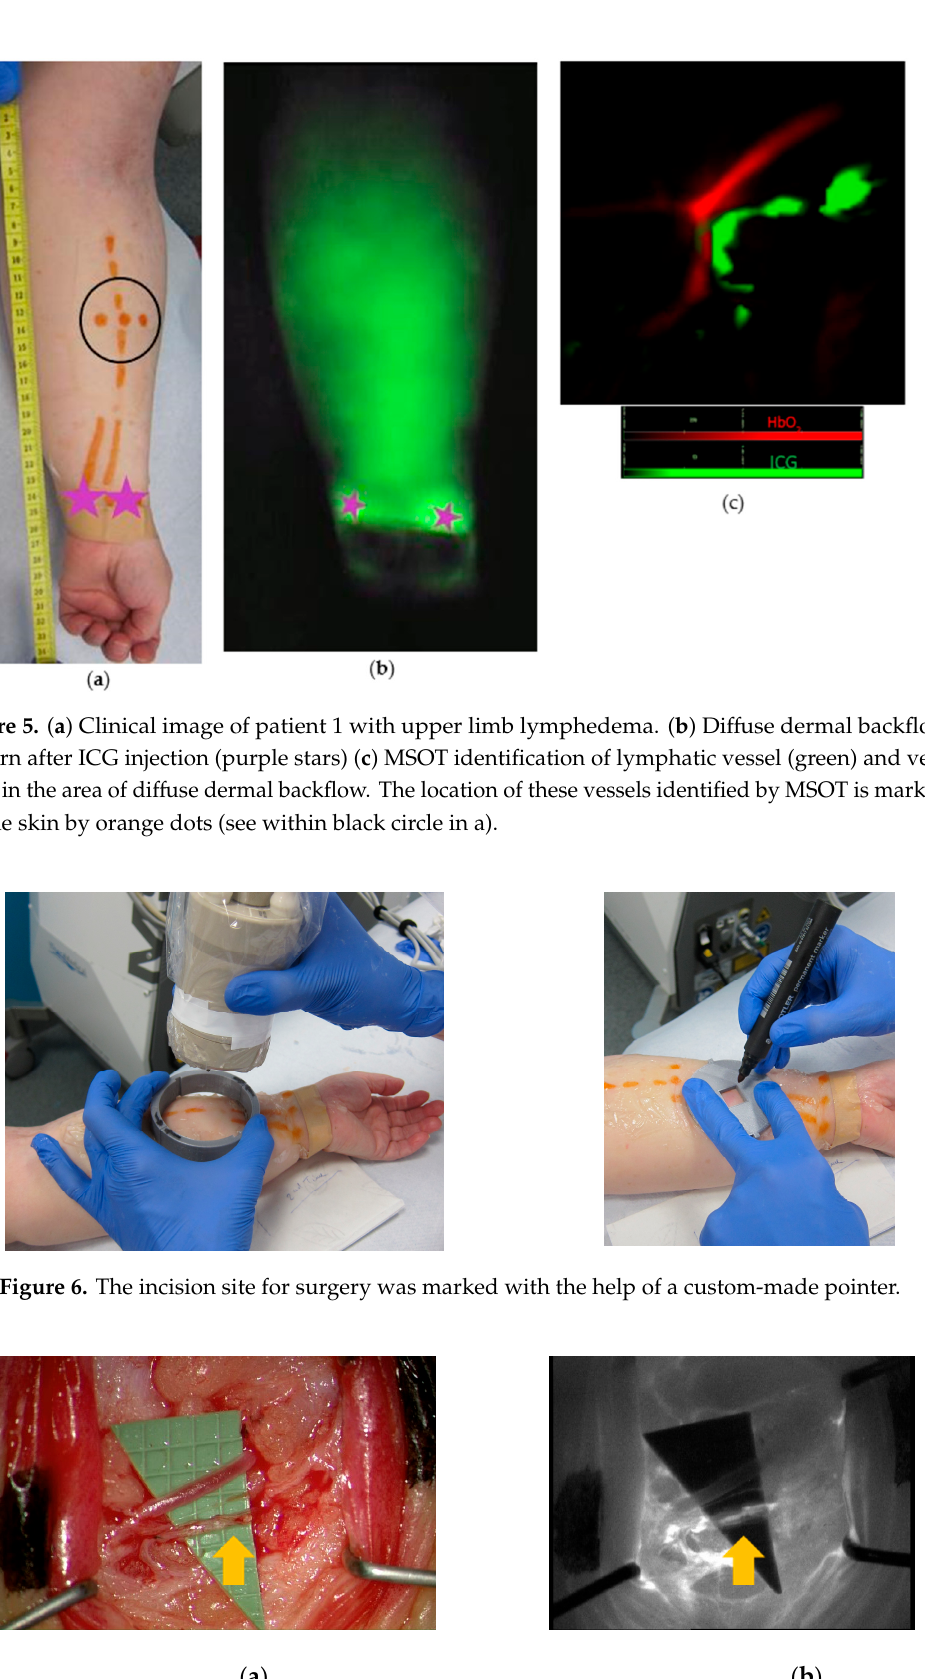
Figure 7. ( a ) Intra-operative visual inspection and ( b ) ICG lymphography confirmed MSOT-identified lymphatic (yellow arrow) and blood vessels. lymphatic (yellow arrow) and blood